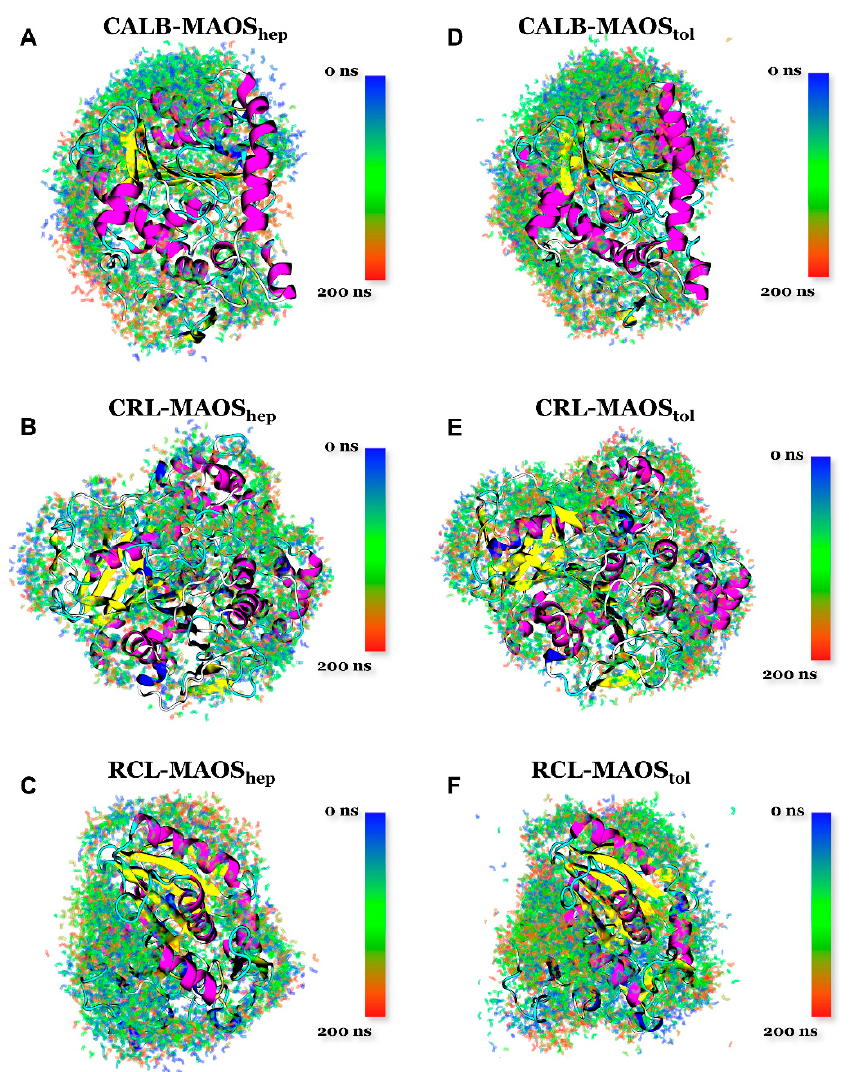
Figure 3. Snapshots of water at different instants in CALB-MAOS hep systems ( A ), CRL-MAOS hep systems ( B ), RCL-MAOS hep systems ( C ), CALB-MAOS tol ( D ), CRL-MAOS tol ( E ), RCL-MAOS tol ( F ). The time scale ranges from 0 ns to 200 ns and this corresponds to blue, green and red colors. Cartoon models of lipase with different colors represent different secondary structures; purple, blue, red, yellow, cyan and white parts represent alpha-helix, 3/10 helix, pi_helix, beta-sheet, turn and coil, respectively. More details of the lipase surface and snapshots of the waters in the MAOS systems are provided in the supplemental video.